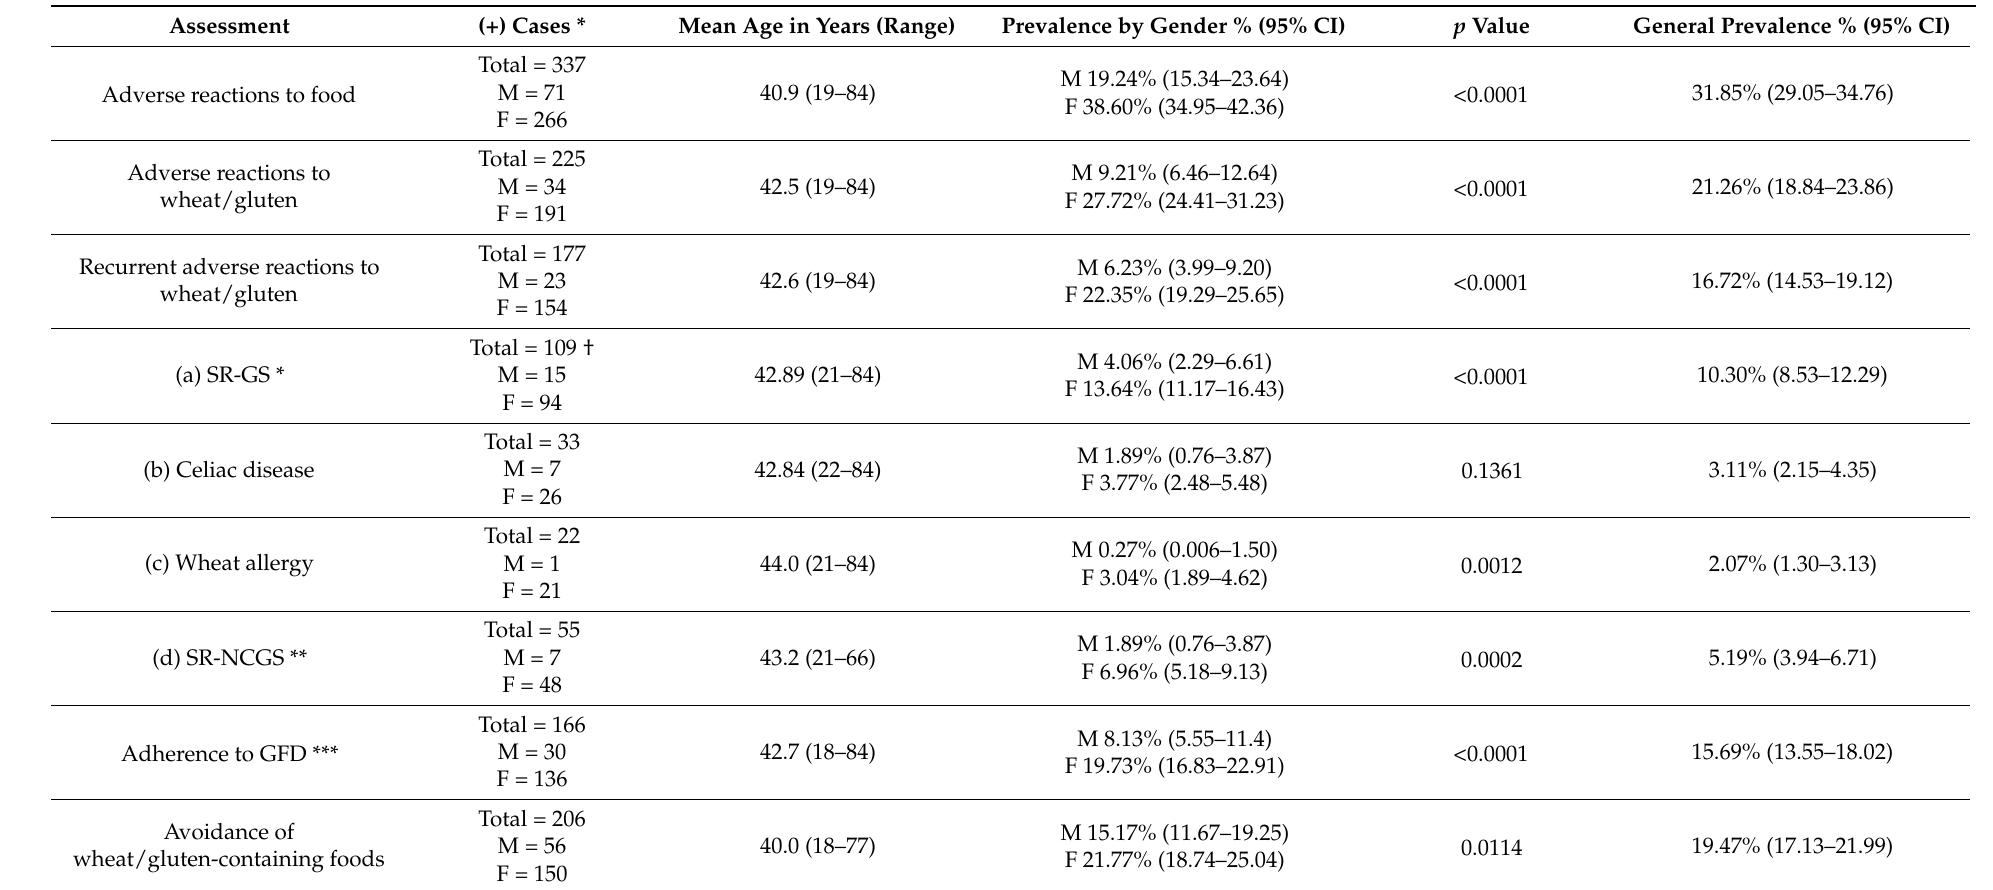
Table 2. Self-reported prevalence rates of adverse reactions to food and